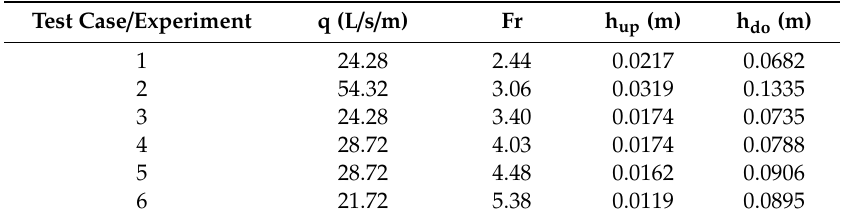
Table 1. Experimental flow variables of the hydraulic